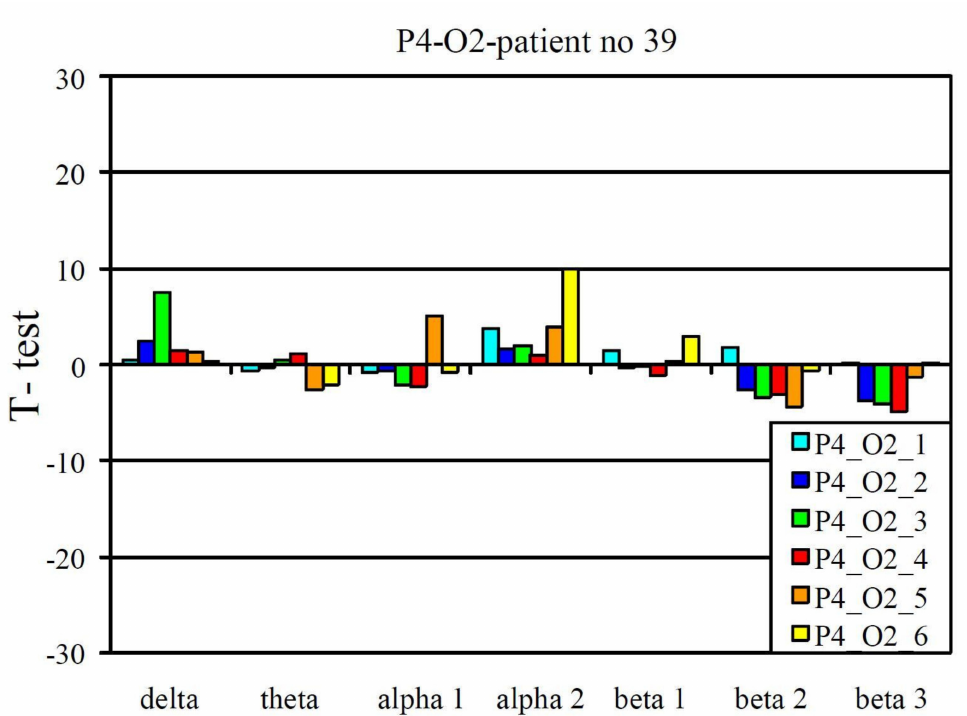
Figure 2. Example of a negative pharmaco-EEG profile during tricyclic antidepressant treatment.